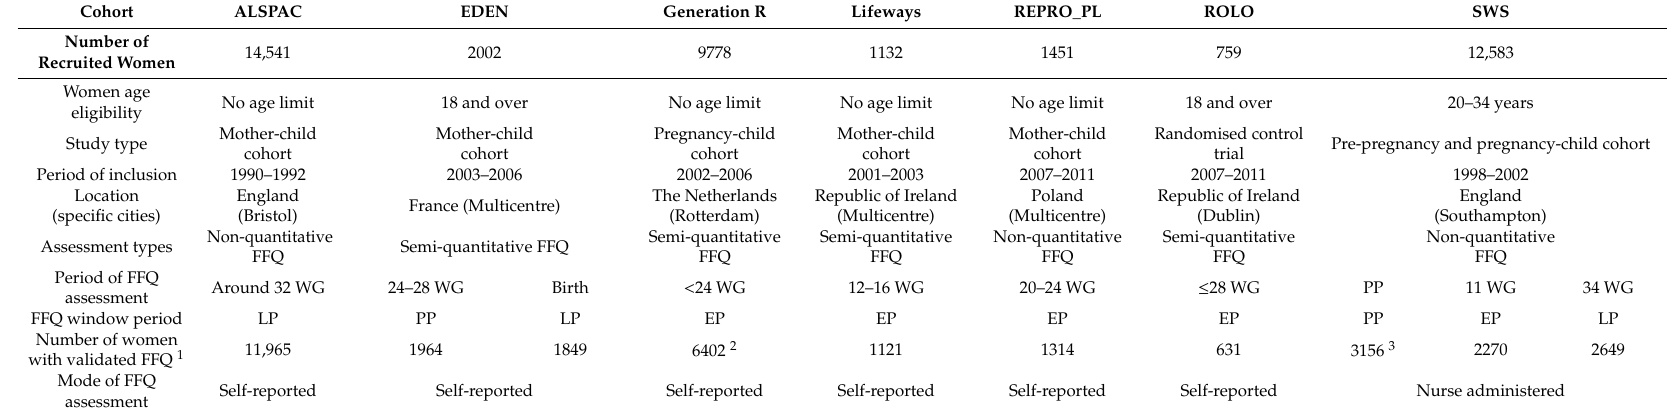
Table 1. Characteristics of the cohorts in the ALPHABET